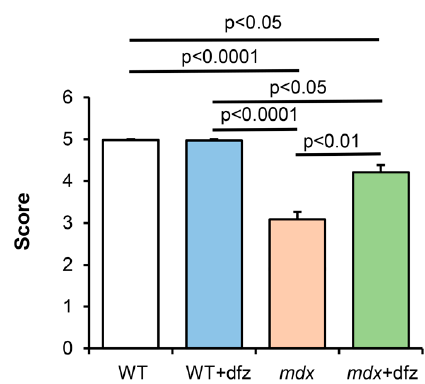
Figure 9. The results of a wire hang test, reflecting muscle function and endurance of the studied groups of mice. The data are presented as means ± SEM ( n = 9).